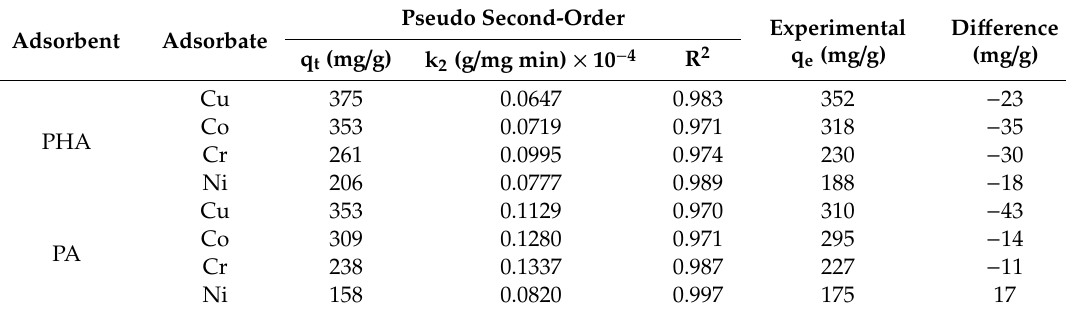
Table 2. Adsorption rates of the pseudo second-order model for transition metals by the polymer chelating ligand (PHA / or PA